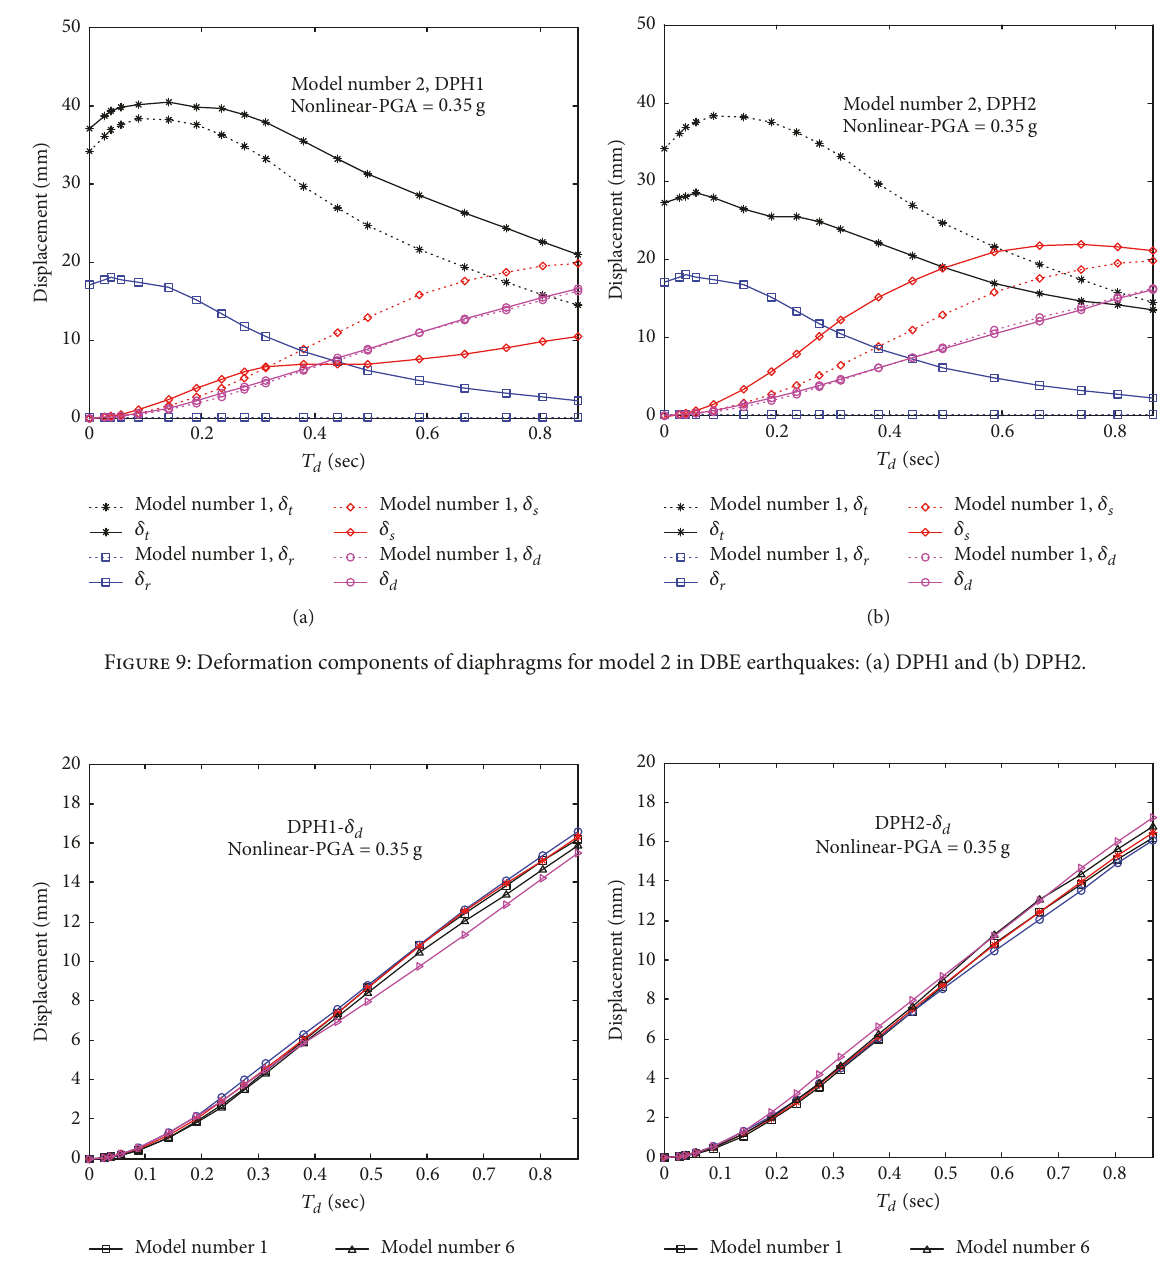
are lesser than that of the strong side diaphragm